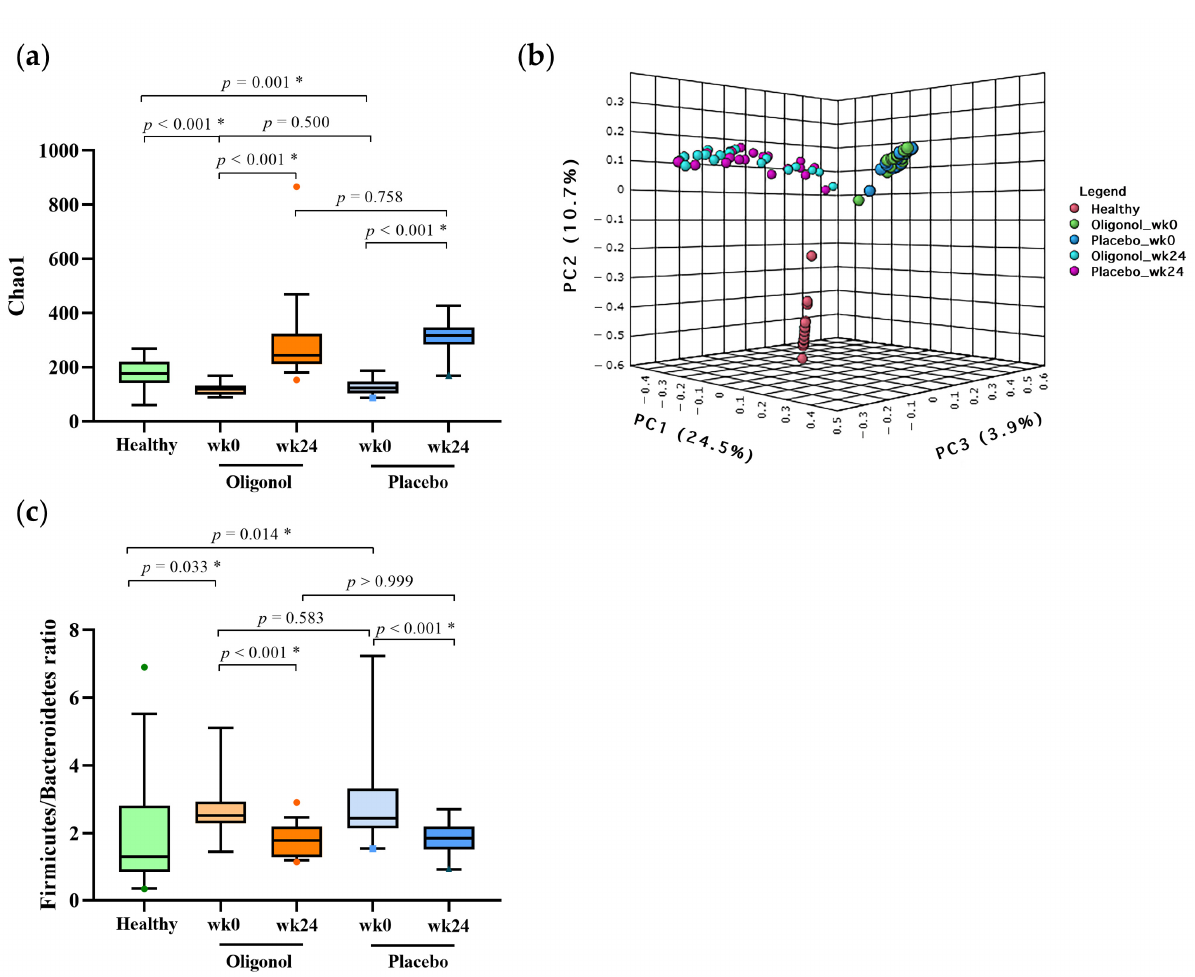
Figure 4. Gut diversities and Firmicute/Bacteroidetes ratio at week 0 and week 24 in the oligonol and placebo groups ( a ) Alpha diversity; ( b ) Beta-diversity (Bray–Curtis distance); ( c ) Firmicute/Bacteroidetes ratio. * p < 0.05; wk0, week 0; wk24, week 24; green dot, the outlier in healthy controls; oranges dot, the outlier in oligonol group; blues dot, the outlier in placebo group, PC, Principal